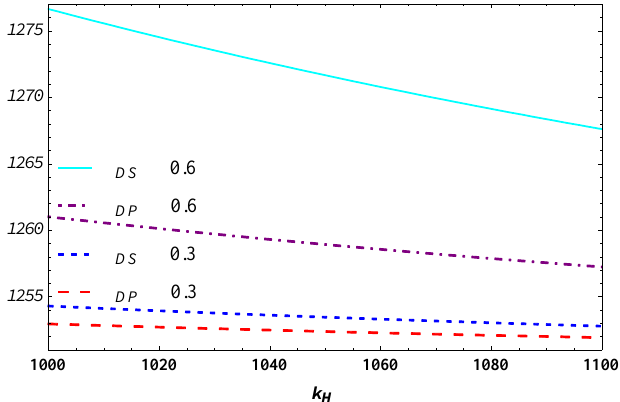
Figure 4. Influence of